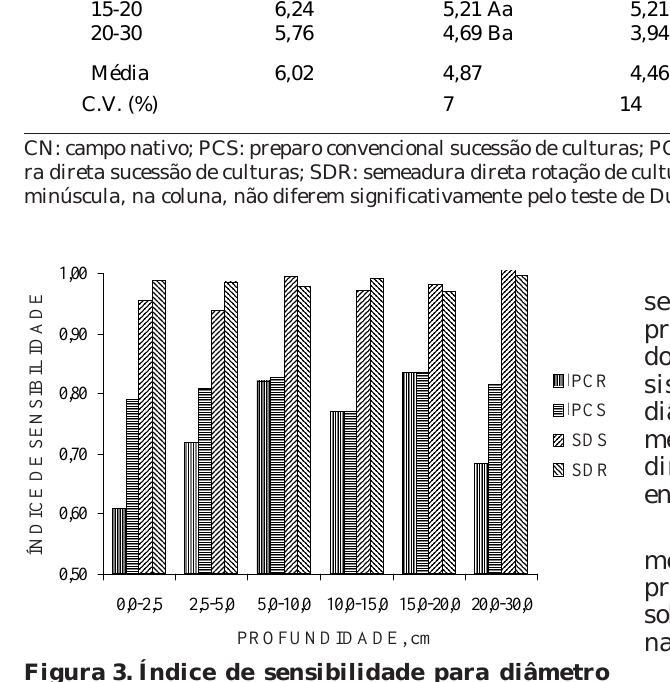
Figura 3. Índice de sensibilidade para diâmetro médio ponderado de agregados, em